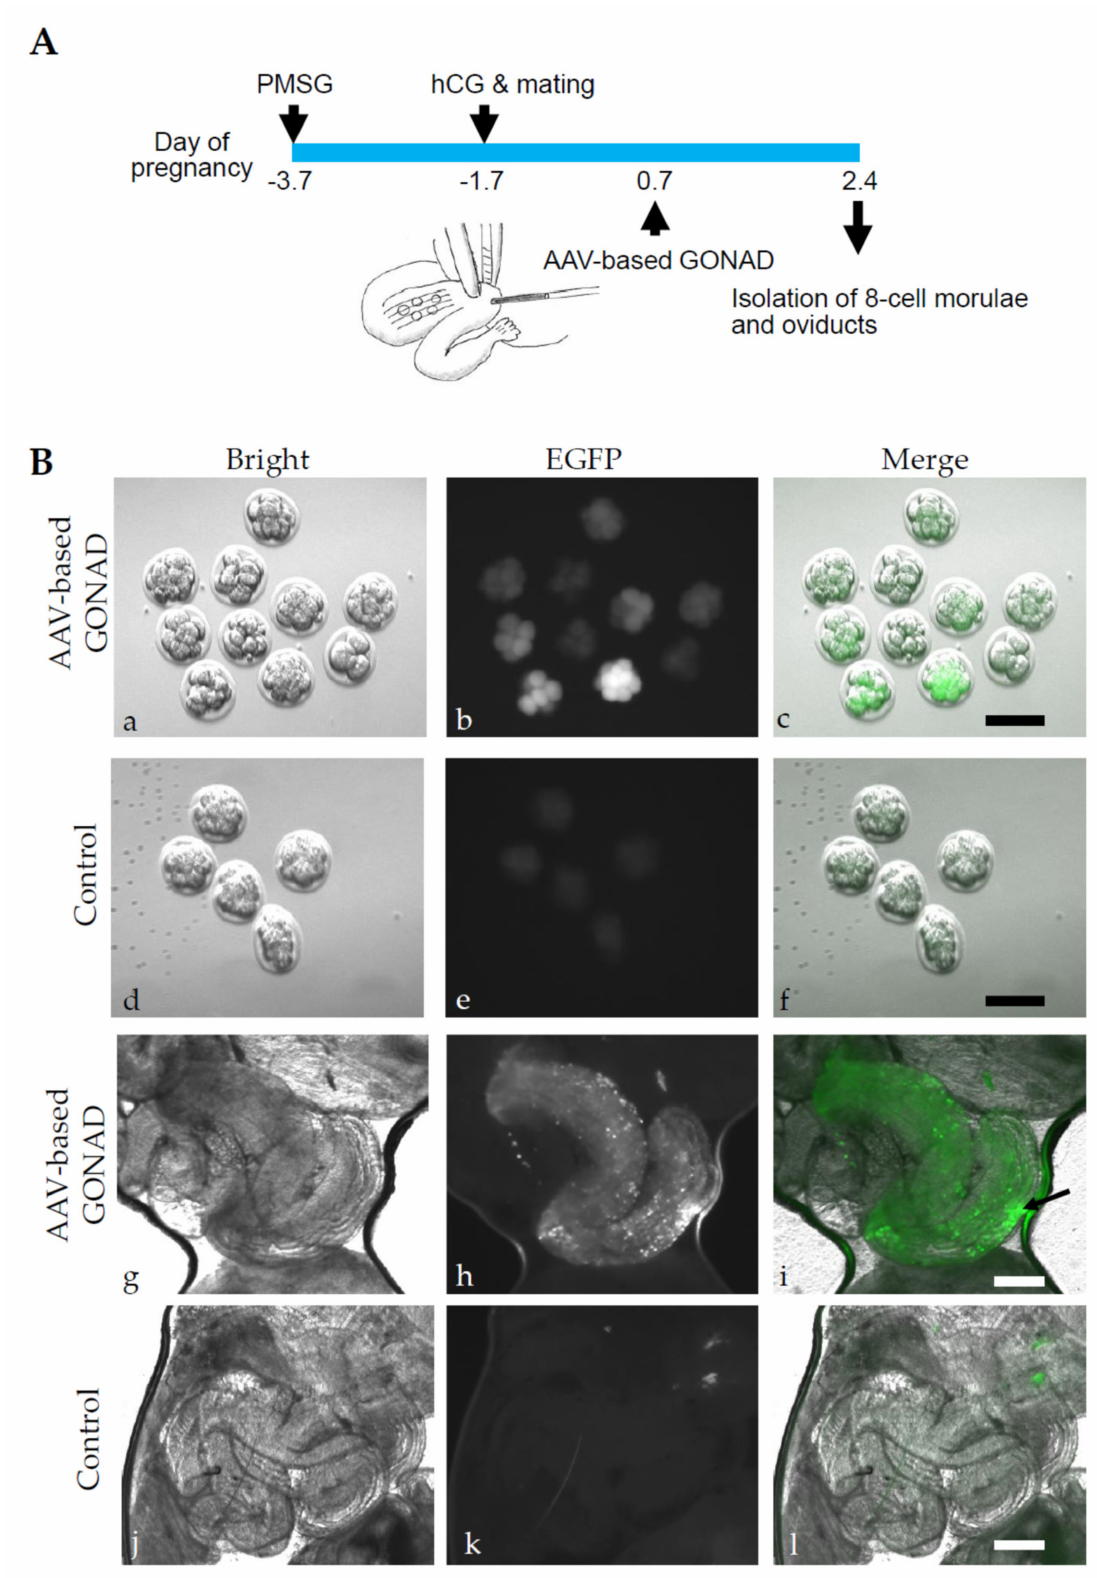
Figure 1. Isolation of morulae and oviducts 2 d after AAV-based GONAD in pregnant B6C3F1 females using scAAV-CAG-EGFP-6. ( A ). Experimental scheme. The B6C3F1 females first received a hormonal treatment of pregnant mare serum gonadotropin (PMSG) and human chorionic gonadotrophin